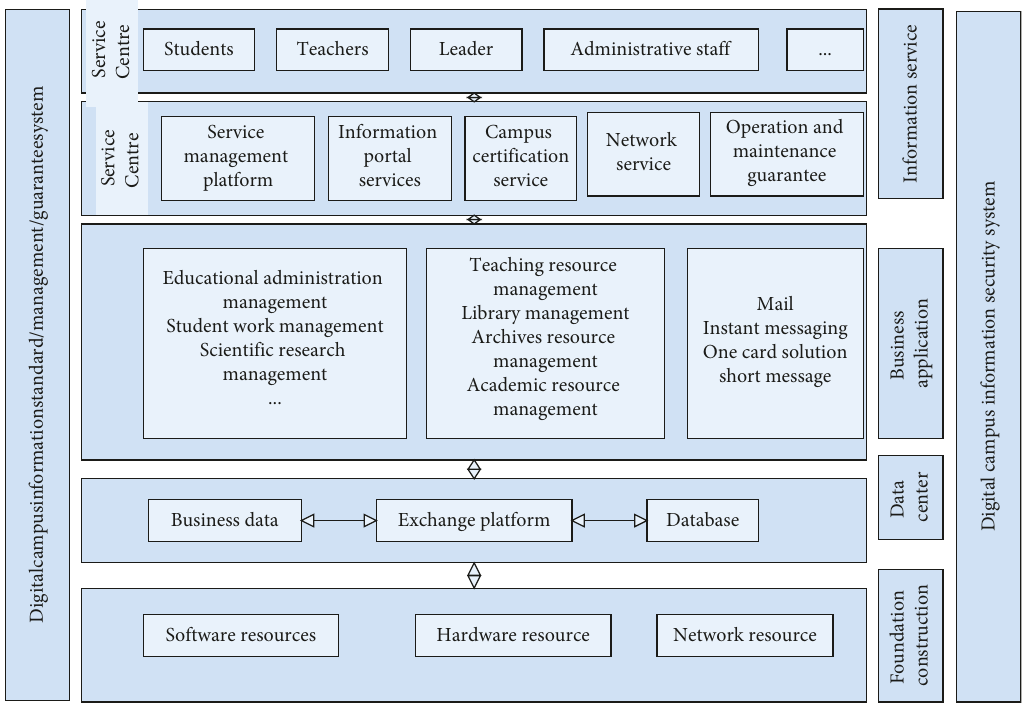
Figure 5: Framework system of the digital information service platform of X-college.